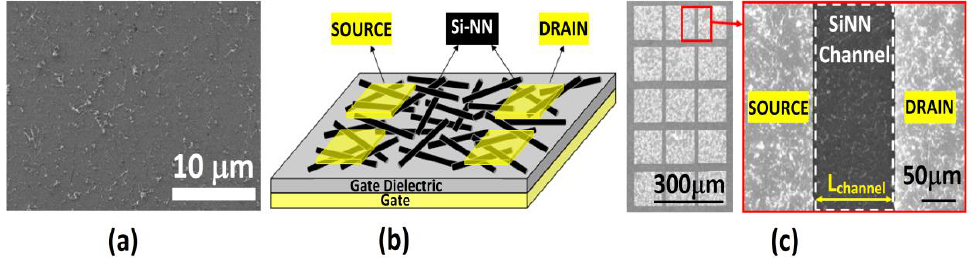
Figure 12. ( a ) SEM image of SiNN ( b ) Si-NN FET structure and ( c ) SEM image of fabricated SiNN FET. Reproduced from [90] under the Creative Commons Attribution License. FET. Reproduced from [90] under the Creative Commons Attribution